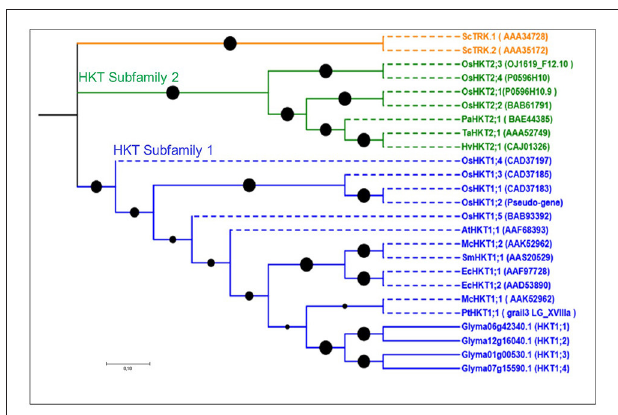
FIGURE 3 | Phylogenetic tree of putative HKT genes in soybean. This family is represented by two subfamilies shown in green and blue. All soybean genes belong to HKT subfamily 1. Reference genes are shown in dotted lines with their NCBI gene names. No common splice site was found in the four soybean HKT